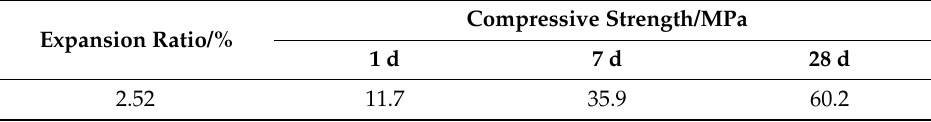
Table 2. Properties of the dry-mixed cement mortar for the CA mortar.